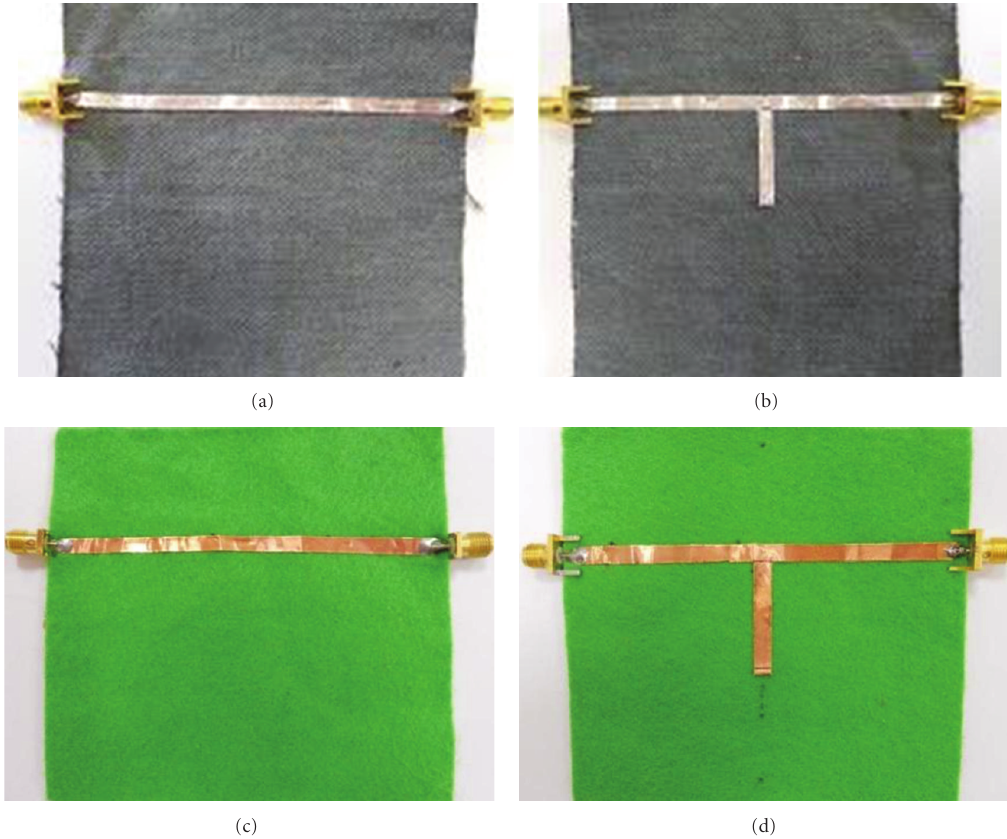
Figure 1: Fabric characterization setup: microstrip line ((a) and (c)) for calibration and open stub ((b) and (d)) for permittivity measurement using denim (up) and felt